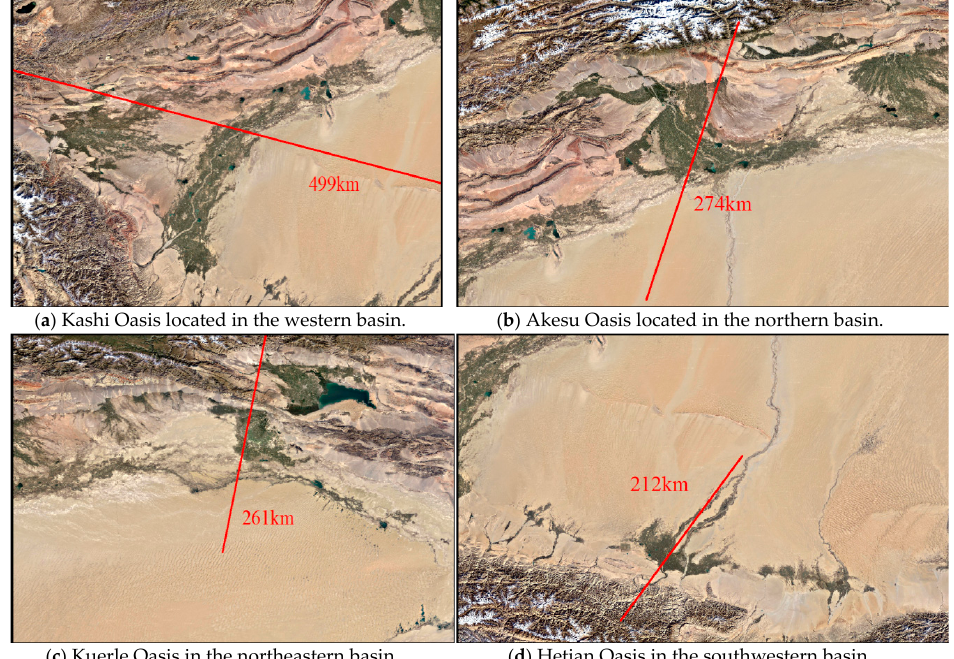
Figure 4. Selected routes of precipitation transition from the desert to oasis in different location of the Tarim Basin, obtained from Google Earth. The permission of Google to use Google Earth Periodicals is given at: